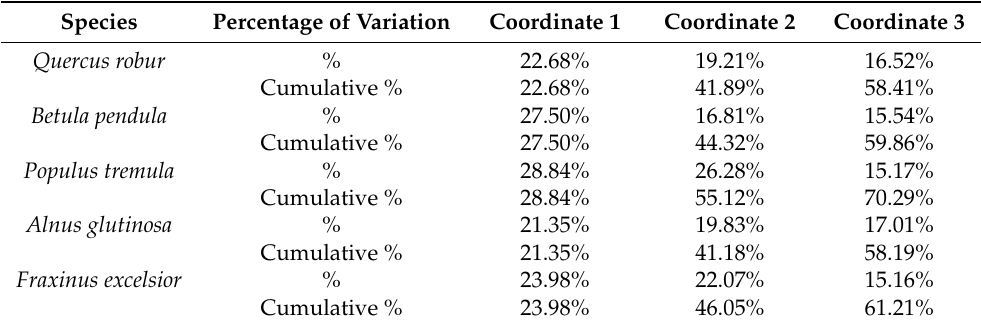
Table 2. The percentages of genetic variation in five broadleaved tree species explained by the first three coordinates of the principal coordinate analysis (PCoA; diagrams presented in Figure